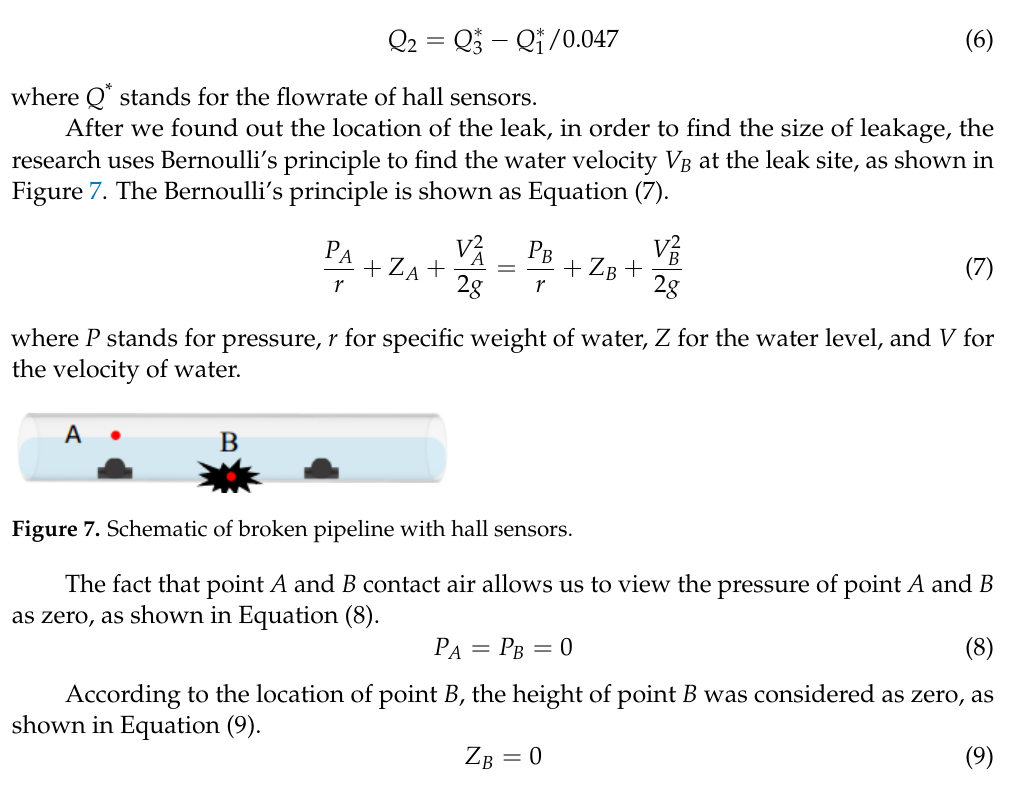
6 of 10 Table 1. The proportion of flowrate of hall sensor to flowrate of pipeline. Flowrate of Hall Sensor (L/h)